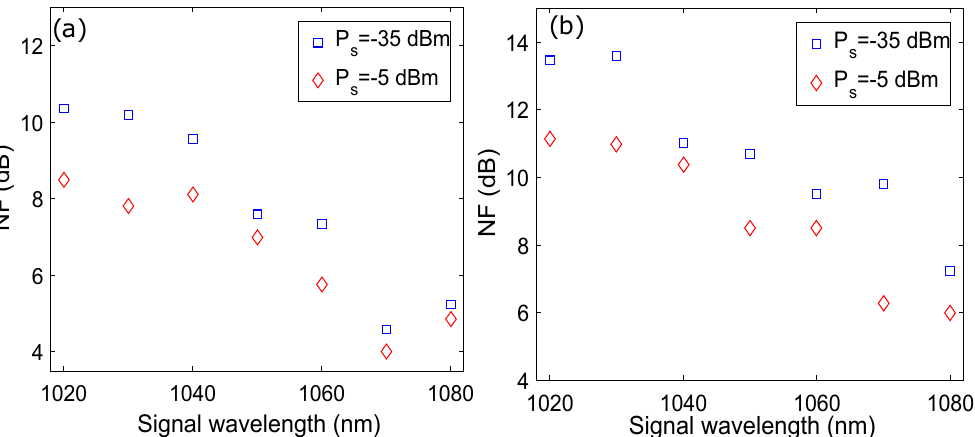
Figure 11. Signalwavelength versus NF plots as a function of signal power when: ( a ) P 1 = 1 W and P 2 = 4 W; ( b ) P 1 = 4 W and P 2 = 1